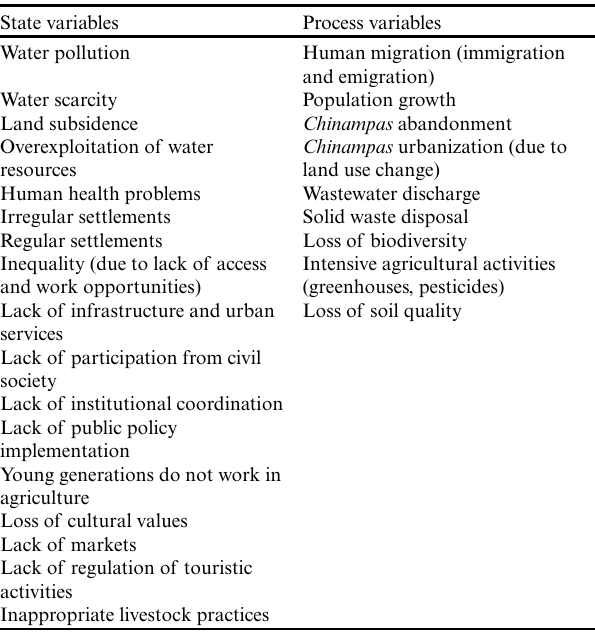
Table 1. List of predefined state and process variables. Fig. 3. Example of a cognitive